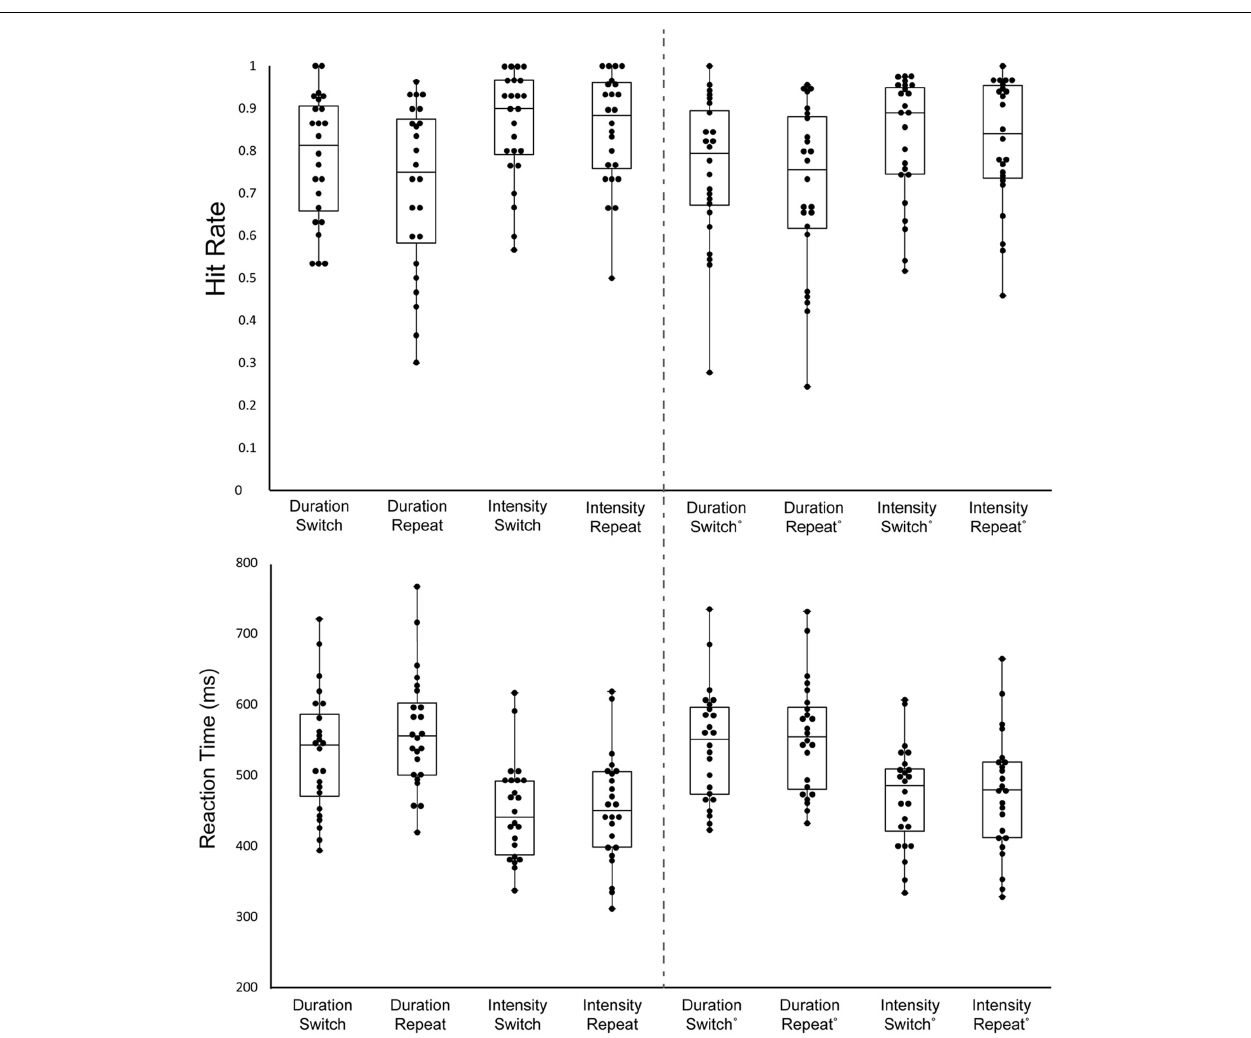
FIGURE 2 | Behavioral results. Hit Rate (HR; top graph) and Reaction Time (RT; bottom graph) are displayed for all stimulus types. Each black circle represents one individual. The upper whisker denotes the upper limit, the lower whisker denotes the lower limit, the upper bar represents the 3rd quartile, the middle bar represents the median, and the lower bar represents the 1st quartile. Each column shows a different stimulus type, indicating whether it was the Duration or the Intensity task and whether the trial was a Switch trial (the previous trial was the other task) or a Repeat trial (the same task repeated). The left columns 1–4 display the mean data of the first target of the trials and the right columns 5–8 display the mean of the remaining targets in the trials.